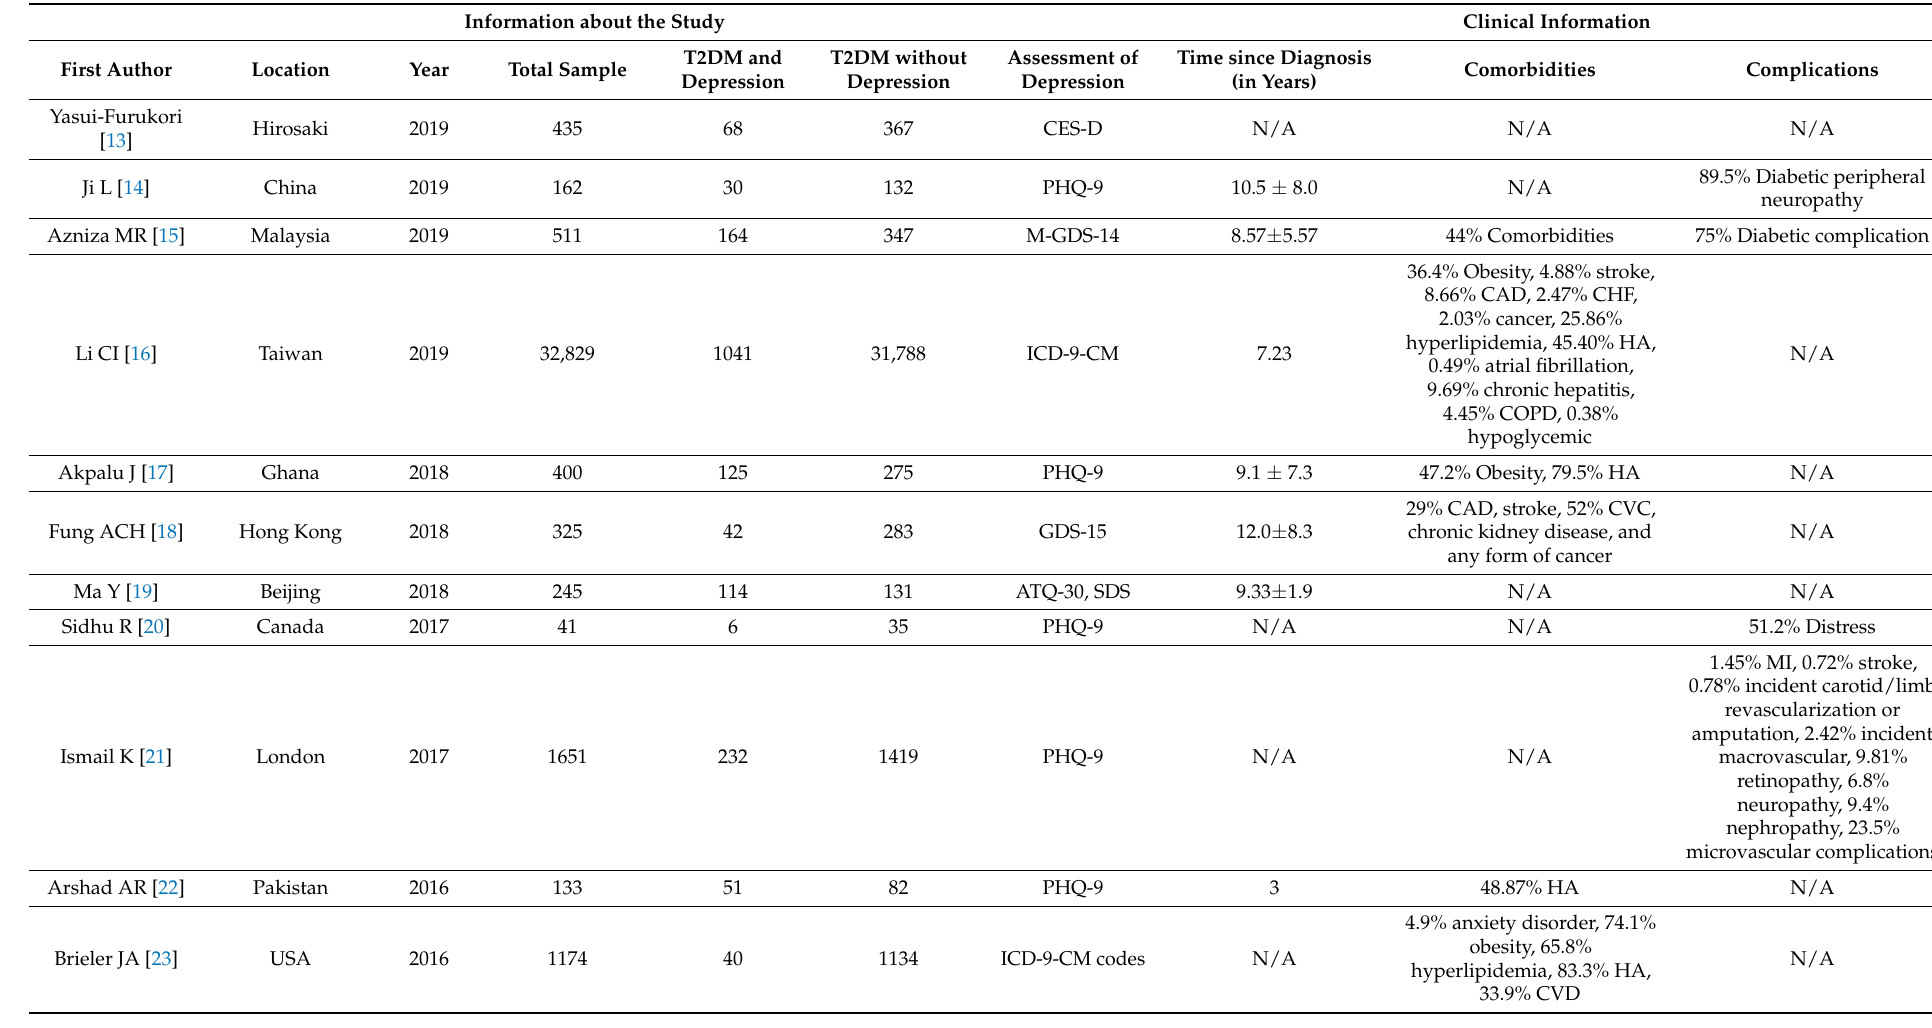
Table 1. Characteristics of the studies included in this